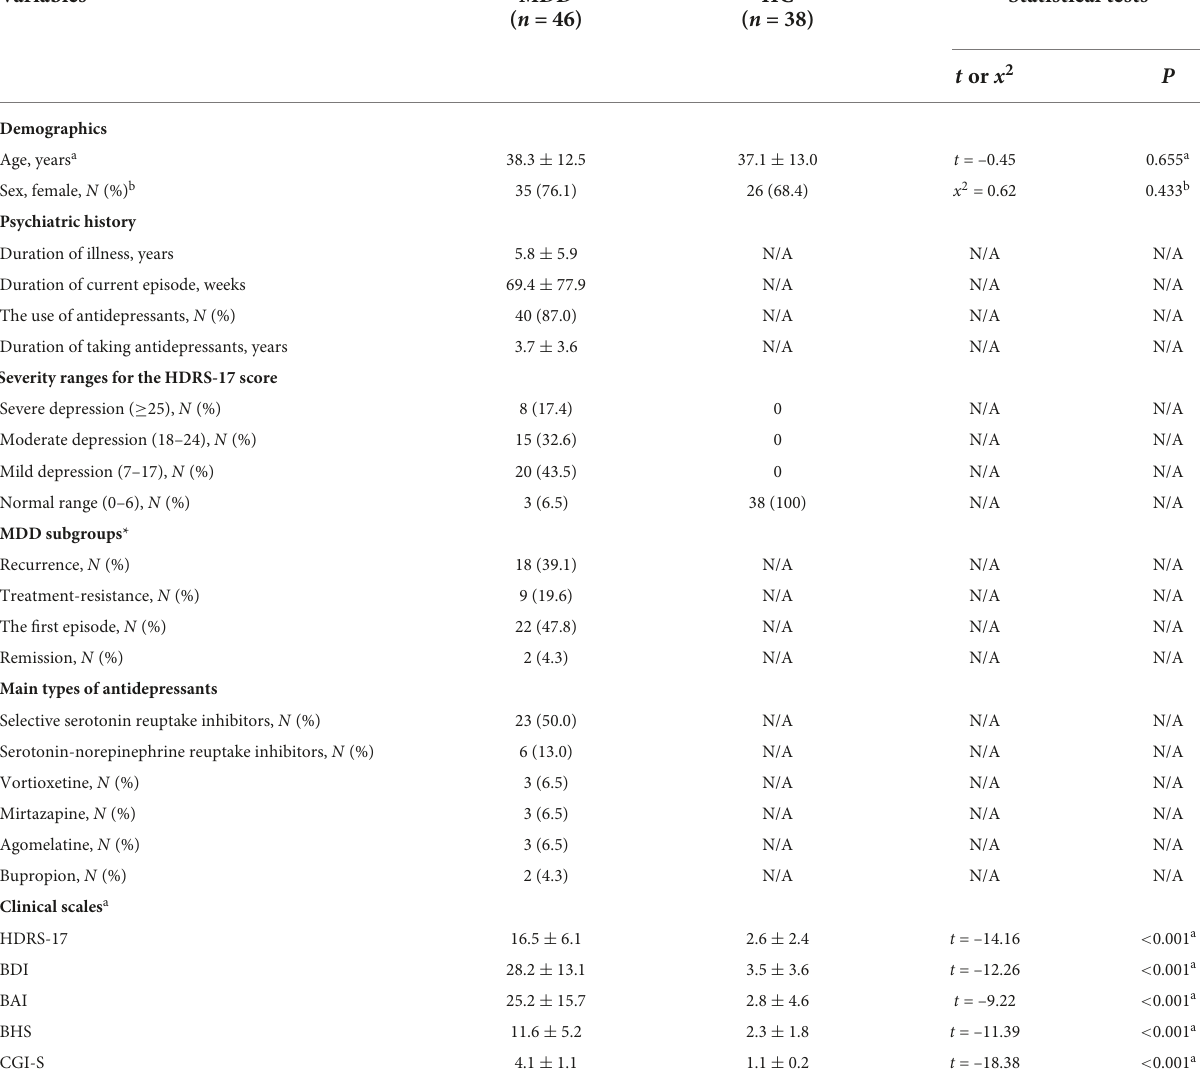
TABLE 1 Demographic and clinical characteristics and their comparison between MDD and HC